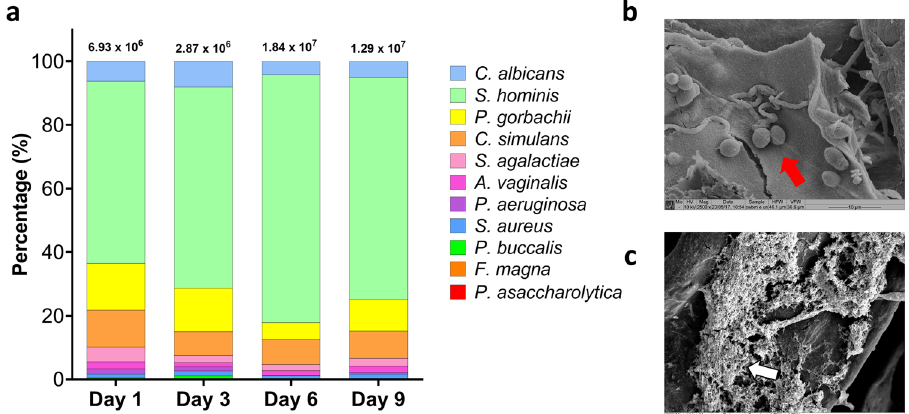
Fig. 1 Compositional and microscopic analysis of the 11-species bio fi lms grown under anaerobic conditions. A total of 10 bacterial species and 1 fungal species were cultured under anaerobic conditions for a total of 9 days. On days 1, 3, 6, and 9, bio fi lms were sonicated, and DNA extracted. Compositional analysis was achieved using species or genus-speci fi c primer sets and qPCR ( a ). Bio fi lms at day 1 and day 9 were imaged using scanning electron microscopy at a magni fi cation of x2500. Fungal yeast cells are highlighted by the red arrow in panel b , whilst the thick extracellular matrix in the mature bio fi lm is indicated using white arrows in panel c . Data for compositional analysis is presented as mean % composition on a log scale for visualisation of all microorganisms. These mean values are taken a total of 2 independent experiments, containing 3 replicates. A more detailed depiction of the % compositional changes in the less abundant microorganisms can be seen in Supplementary Fig 2. CFE/mL values with standard deviation for each microorganism for each condition and across all timepoints are shown in Supplementary Fig